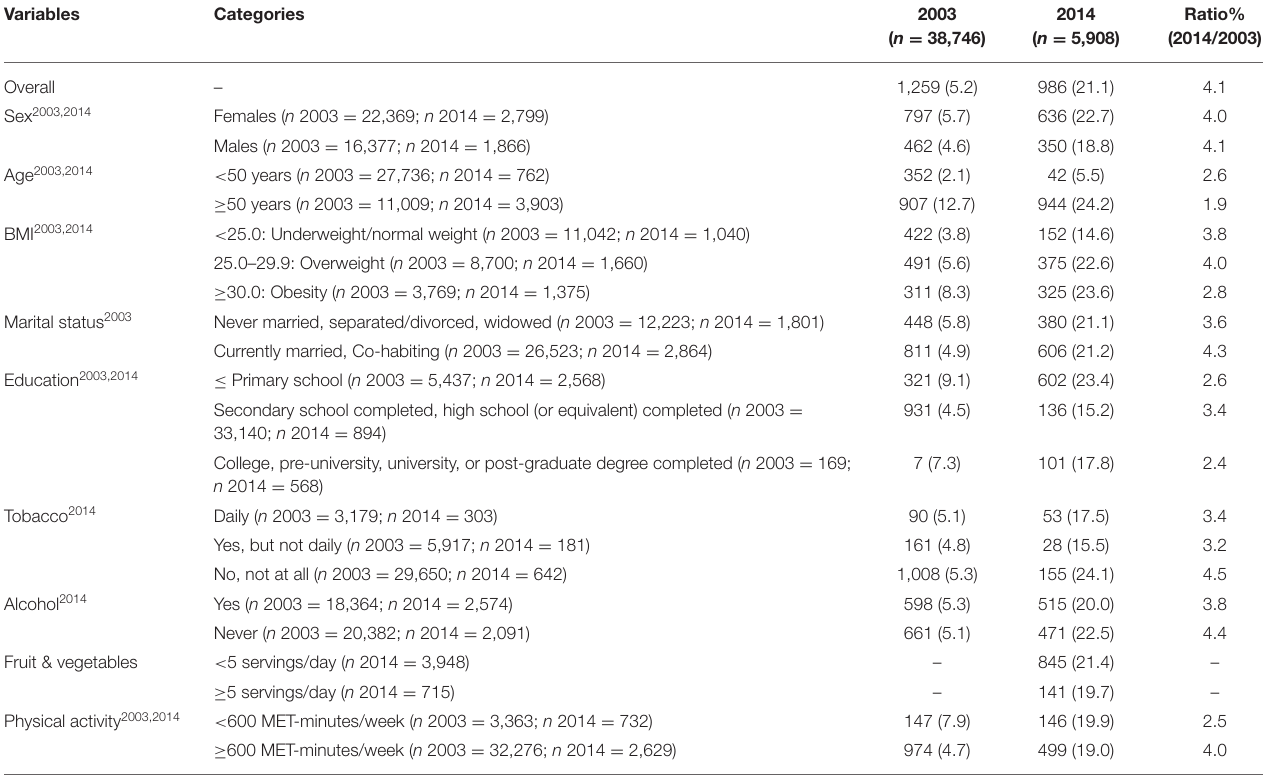
TABLE 1 | Prevalence of diabetes mellitus (outcome) in Mexican adults, by year and exposure